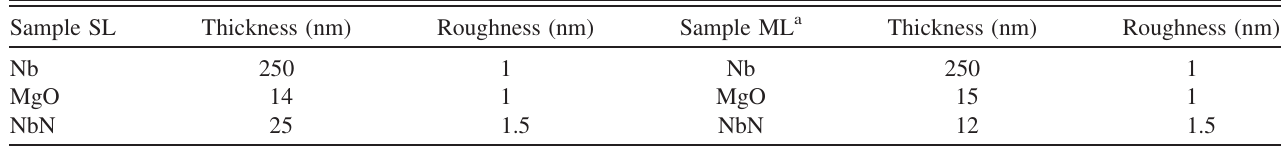
TABLE I. Summary of the x-ray reflectivity